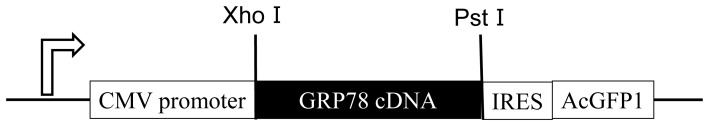
Schematic illustration of the pIRES2-AcGFP1 plasmid constructs used in the present study.cDNA of the rat GRP78 carried the XhoI/PstI cut sites and was cloned into the pIRES2-AcGFP1 plasmid.